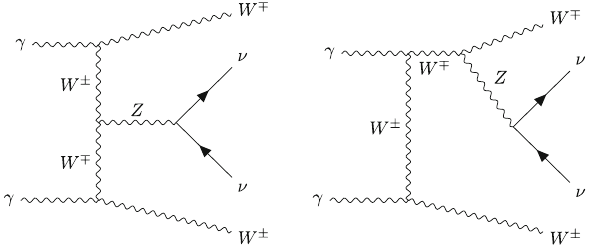
Fig. 5 Example Feynman diagrams for the dominant SM background γγ → W + W − Z with Z → ν ¯ ν in our analysis